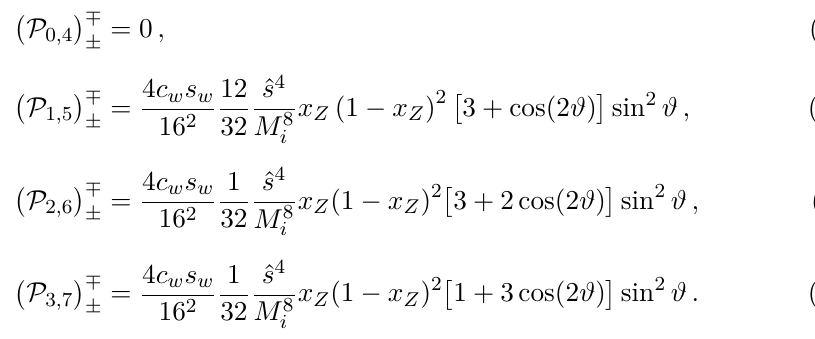
sections at the gluon-gluon collision energy appear. However, these differences are proportional to the scale factor x x → 0 all the curves in the left panel of figure 11 converge to forms ∝ 1 + cos 2 θ ? Z